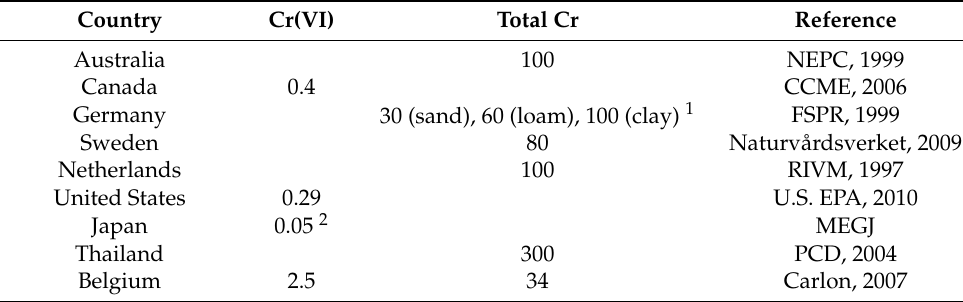
Table 6. Risk-based screening levels of Cr in some countries (mg/kg). Country